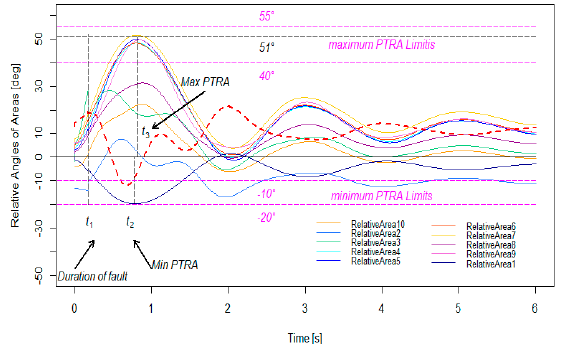
Figure 5. Relative oscillation of the power system for a three-phase fault in Line 4-5 cleared at 0.17 s.